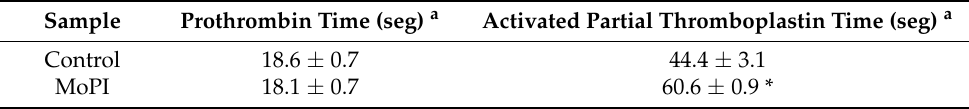
Table 4. Anticoagulant activity of MoPI on activated partial thromboplastin and